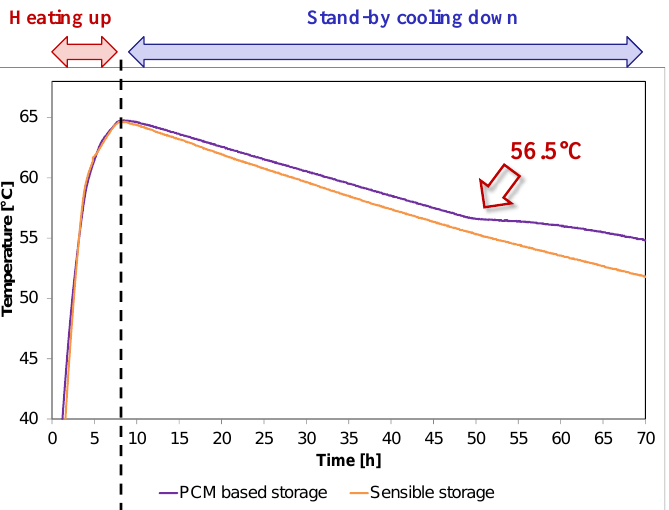
Figure 5. Temperature evolution inside the internal tank of the hybrid TES system during the stand-by cooldown process. The reference thermocouple is the T tank, as represented in Figure 4.